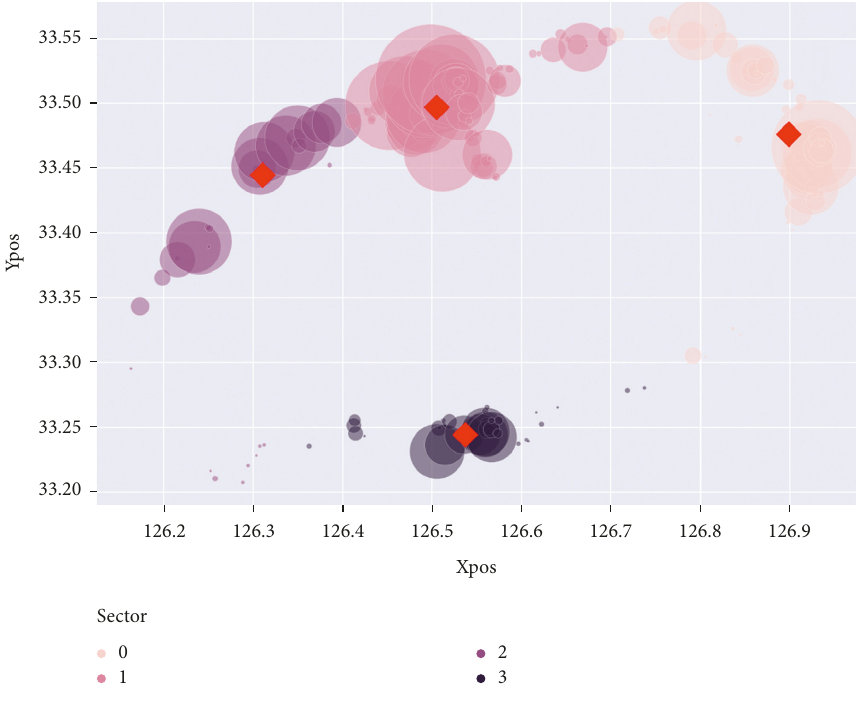
Figure 12: Clustering with four sectors.